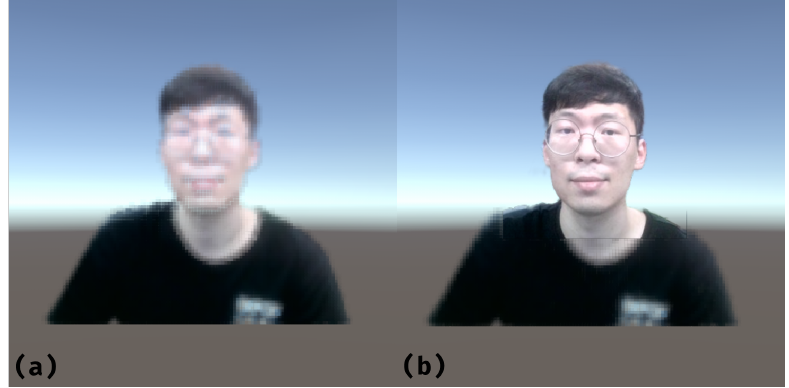
Figure 4. ( a ) Low-resolution point cloud head. ( b ) High-resolution 2D plane